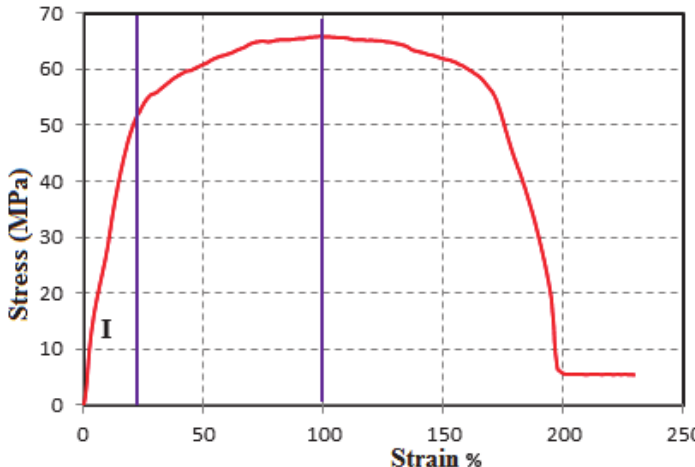
Figure 1: Stress-strain curve obtained from a tensile test on PA66 polyamide